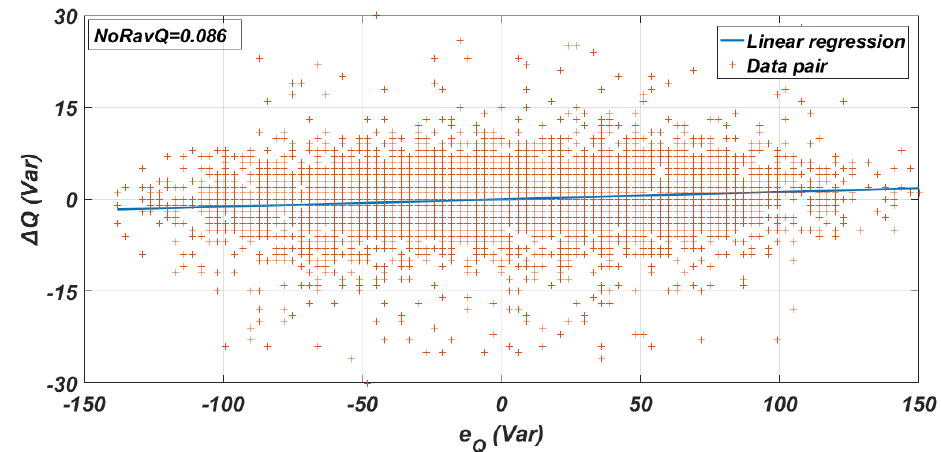
Figure 6. Plot and linear regression of [ e Q ( t ), ΔQ ( t )] pairs used for the calculation of NoRavQ for the properly configured PTMVR control method.